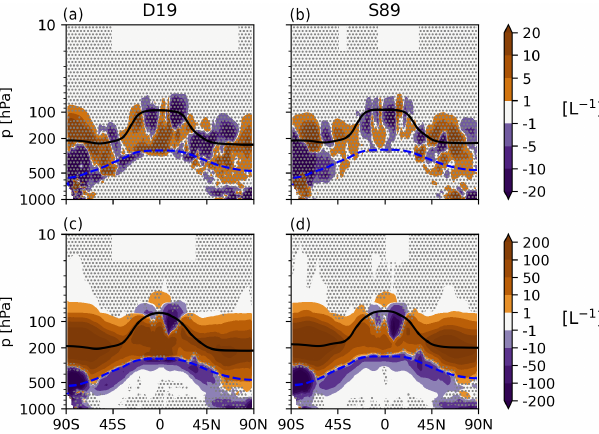
Figure 5. Five-year zonal mean ICNC S i,seed = 1.05 anomalies in L − 1 for both the D19 and S89 ice cloud fraction approaches. Seed1 anomalies are presented in panels (a) and (b) , and Seed100 anoma- lies are presented in panels (c) and (d) . The black line is the 5-year mean zonal mean WMO-defined tropopause height on pressure lev- els, and the blue dashed line is the 238K isotherm. The stippling in the difference plots shows insignificant data points on the 95% confidence level according to the independent t test controlled by the false discovery rate